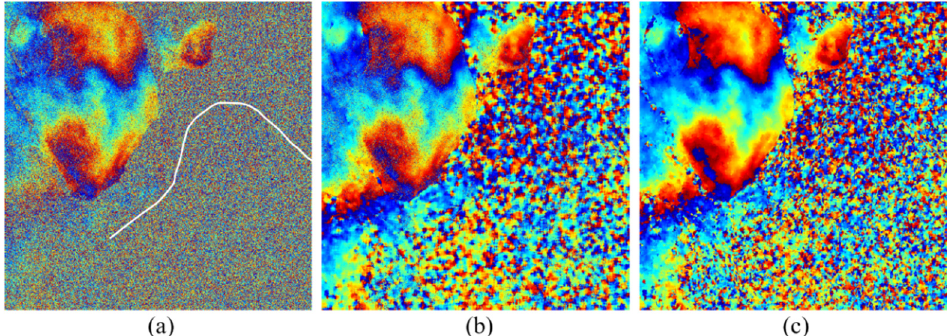
Figure 13. The interferograms of “20110517–20111101”. ( a ) The original HH interferogram; ( b ) The filtered interferogram with PHP; ( c ) The filtered interferogram with PIHP.